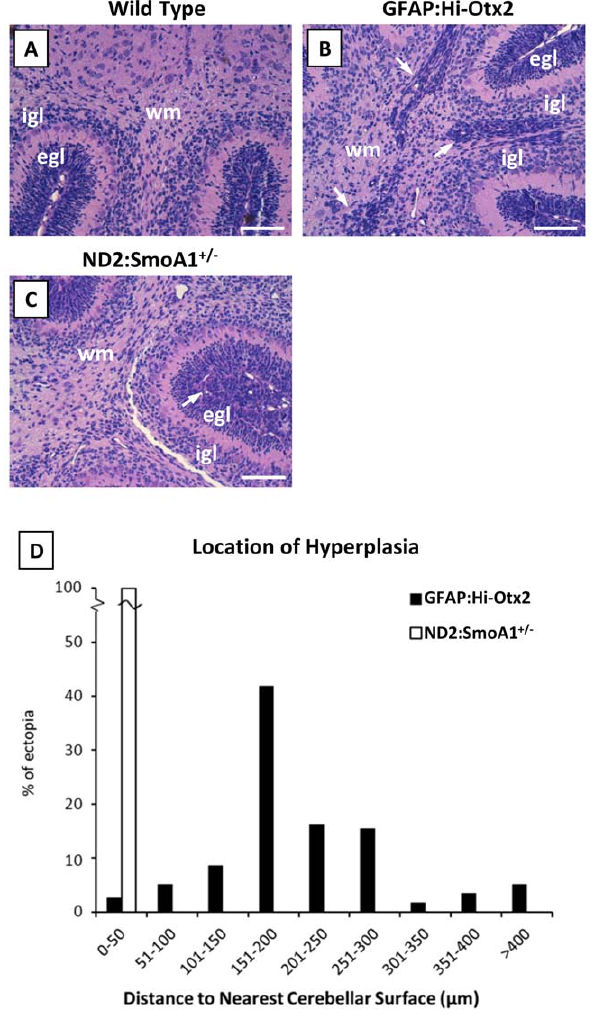
Figure 5. Cerebellar hyperplasias in GFAP:Hi-Otx2 mice are spatially distinct from dysplasia/hyperplasia observed in ND2:SmoA1 + / 2 mice. Images of H & E stained sections (20 6 mag) from (A) wild type mice, (B) GFAP:Hi-Otx2 mice, and (C) ND2:SmoA1 + / 2 mice. Scale bar: 100 m m. (D) Location of ectopia at P7 in GFAP:Hi-Otx2 mice relative to location of hyperplasia/dysplasia in P7 ND2:SmoA1 + / 2 mice. Arrows indicate regions of hyperplasia.